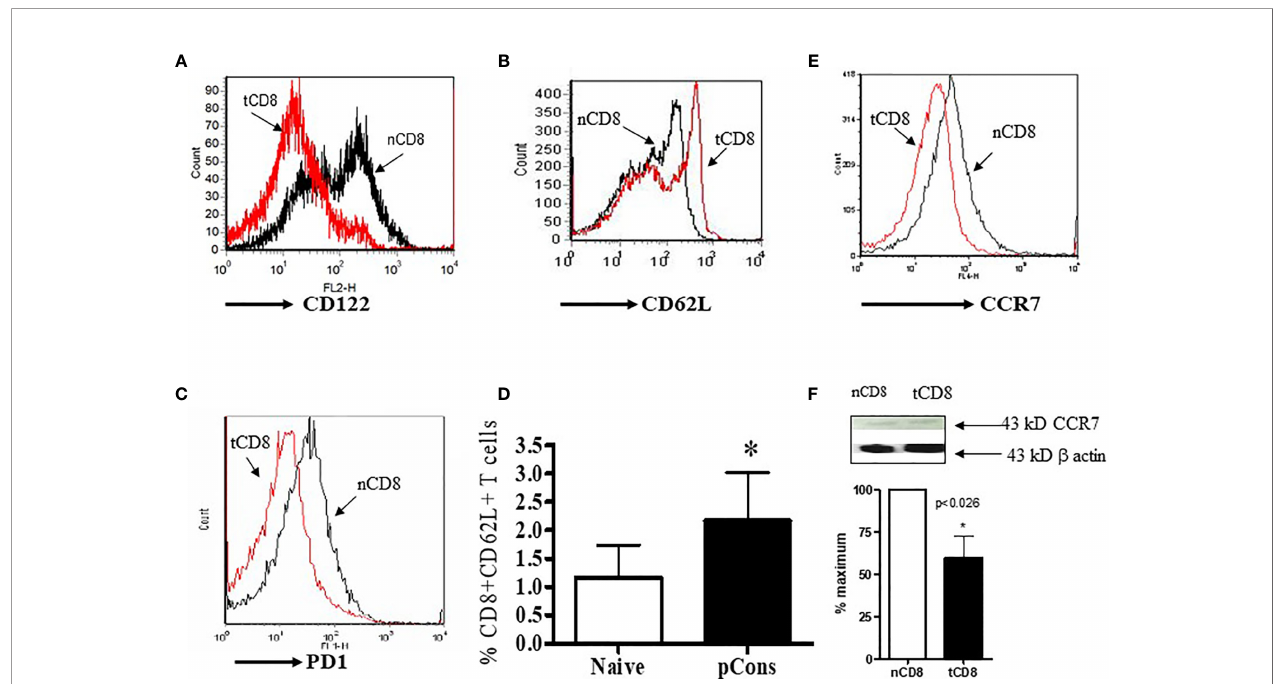
FIGURE 2 | pCons treatment modi fi ed the cell surface expression of CD122, CD62L, CCR7, and PD1 in CD8 + T cells in BWF1 mice. Female 10-12-wk old BWF1 mice were treated with pCons (1 mg i.v. ). After one-two week treatment, splenocytes were obtained both from naïve and pCons-treated BWF1 mice (2-3 mice in each group). RBC lysed, cells washed and stained with speci fi c antibodies (CD8, CD62L, CD122, CCR7), and fl ow cytometry performed. (A) CD122 (PE) cell surface expression of naïve vs tolerized CD8 + T cells treated with pCons; (B) CD62L (FITC) cell surface expression of naïve vs tolerized CD8 + T cells pCons; (C) PD1 (PE) cell surface expression of naïve vs tolerized CD8 + (pCons); (D) Percent expression of naïve CD8 + CD62L + vs tolerized CD8 + CD62L + T cells (pCons); (E) CCR7 (APC) cell surface expression of naïve CD8 + vs tolerized CD8 + T cells (pCons-treated group). Minimum 10,000 cells were gated, and live cells were used for data analyses. Dead cells were excluded from the analyses. Data were analyzed with FCS Express Ver. 7 ( De Novo , Ontario, Canada). *p < 0.05. (F) Naïve CD8 + and tolerized CD8 + T cells were obtained, lysed, and Western Blot analysis performed with CCR7 and b -actin antibodies. CCR7 value normalized to those of b − actin. *p <